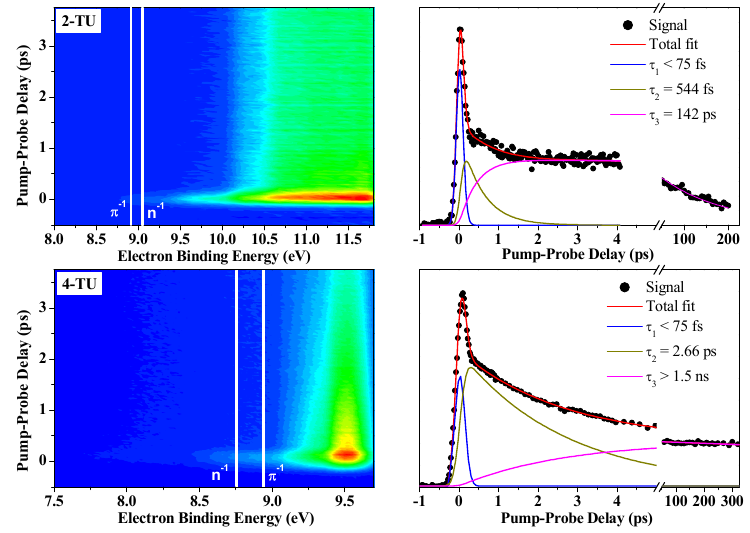
Fig. 1. TRPES spectra of 2-TU (top, left) and 4-TU (bottom, left) following photoexcitation close to their UV absorption maximum. The 2d plots are truncated to a pump-probe range of ~4ps for clarity; photoelectron spectra are plotted as a function of electron binding energy, which is calculated as the total photon energy minus the measured photoelectron kinetic energy, for direct comparison to ionization potentials (indicated as white lines). 2- TU: IP(  -1 )=8.891eV, IP(n -1 )=9.013eV; 4-TU: IP(n -1 )=8.75eV, IP(  -1 )=8.918eV [3]. The associated timetraces (right) were extracted assuming sequential decay dynamics of three exponentials convoluted with the Gaussian